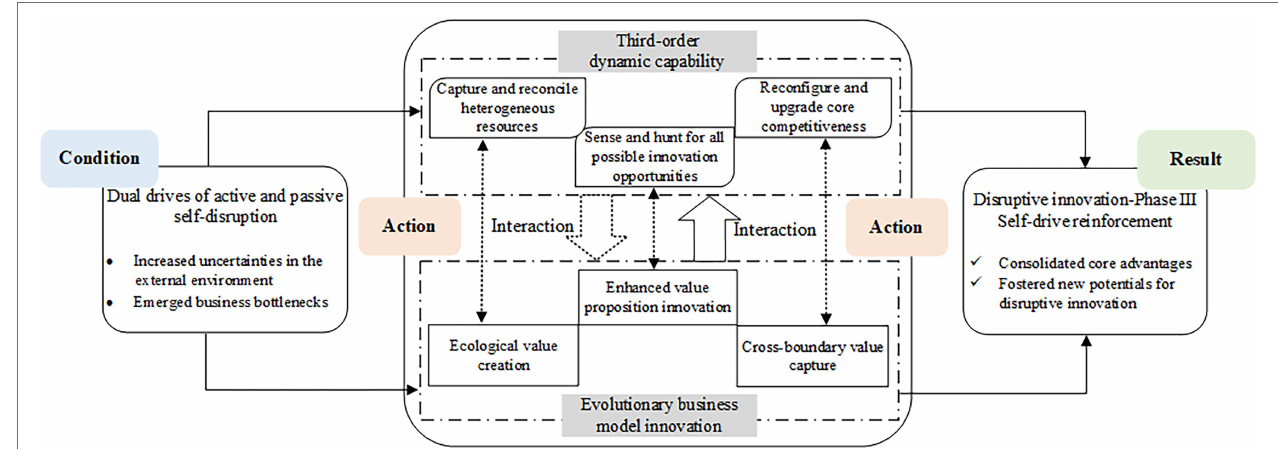
FIGURE 3 | The happening mechanism of ByteDance’s self-drive reinforcement phase.